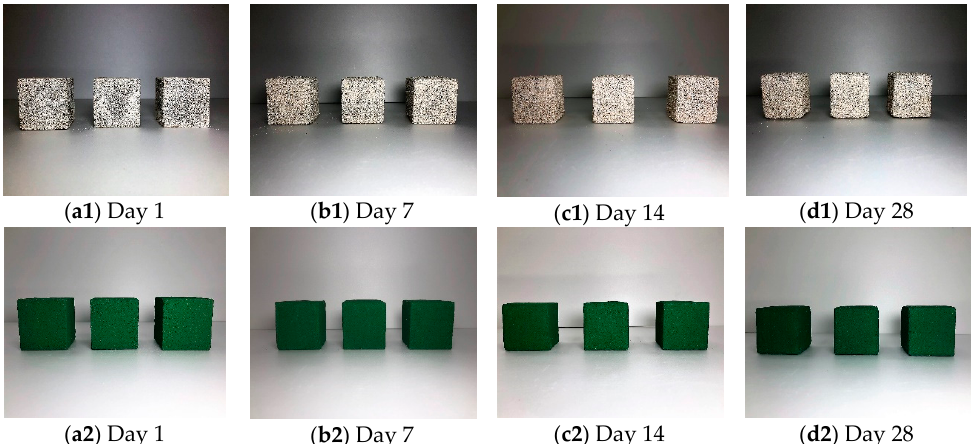
Figure 5. Specimens submerged in sulphuric acid.